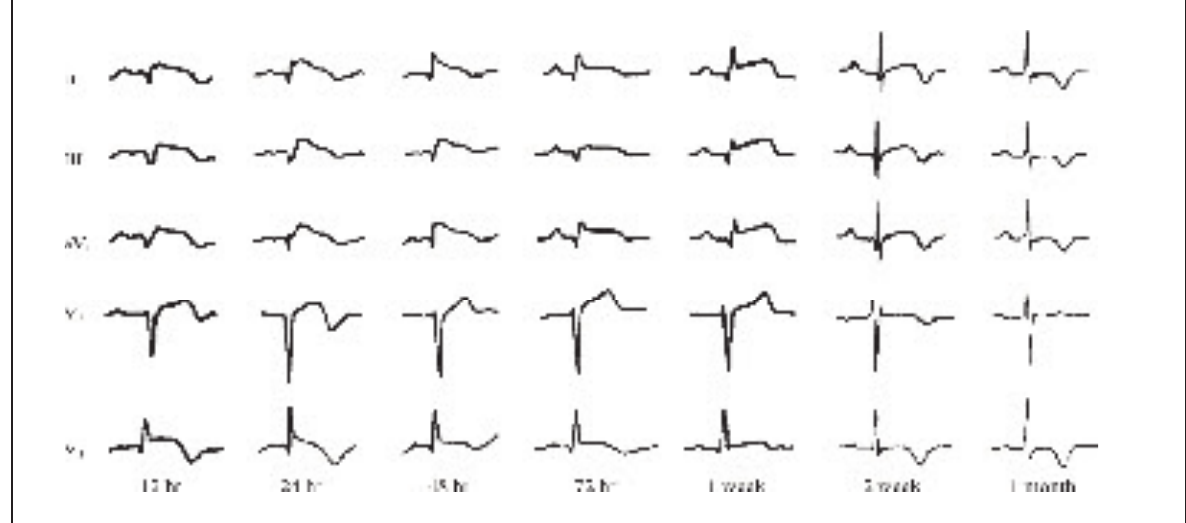
Fig.1: ECG changes – ST elevation in II, III, AVF in Takotsubo